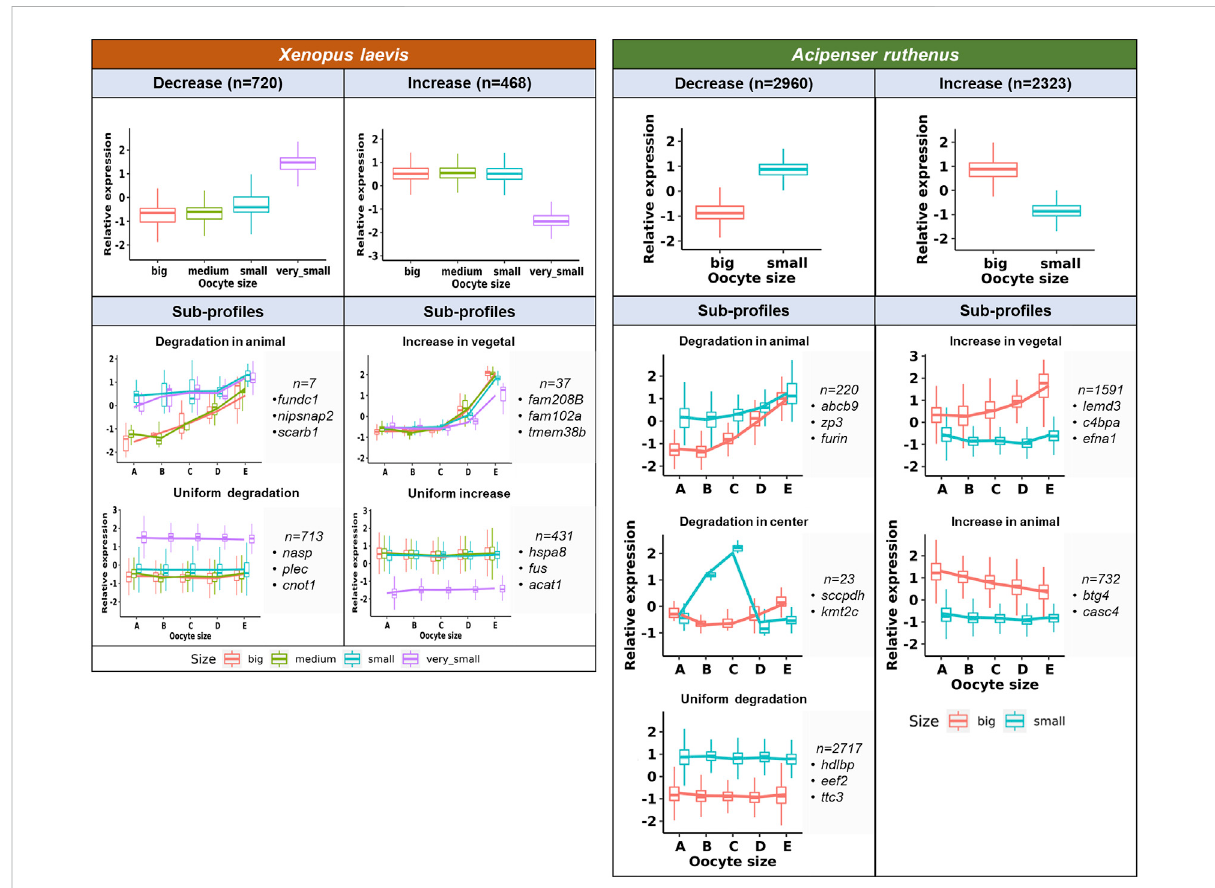
FIGURE 6 Unique pro fi les representing the signi fi cant total transcript count alterations between the different oocyte sizes of the Xenopus laevis and Acipenser ruthenus. The sections correspond to the regions of the oocyte that were cryosectioned, whereby sections A - extremely animal, B - animal, C - central, D - vegetal, E - extremely